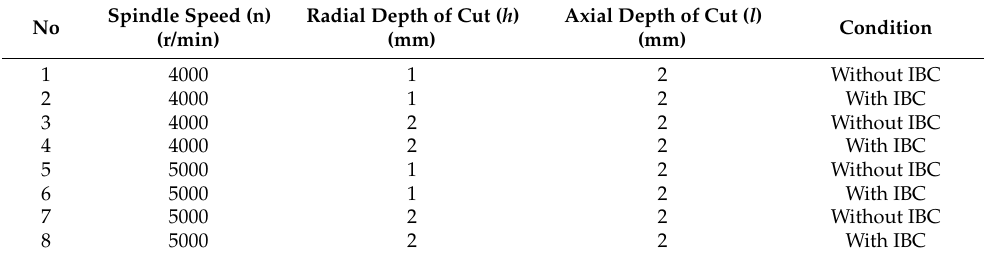
Table 8. Experimental design.